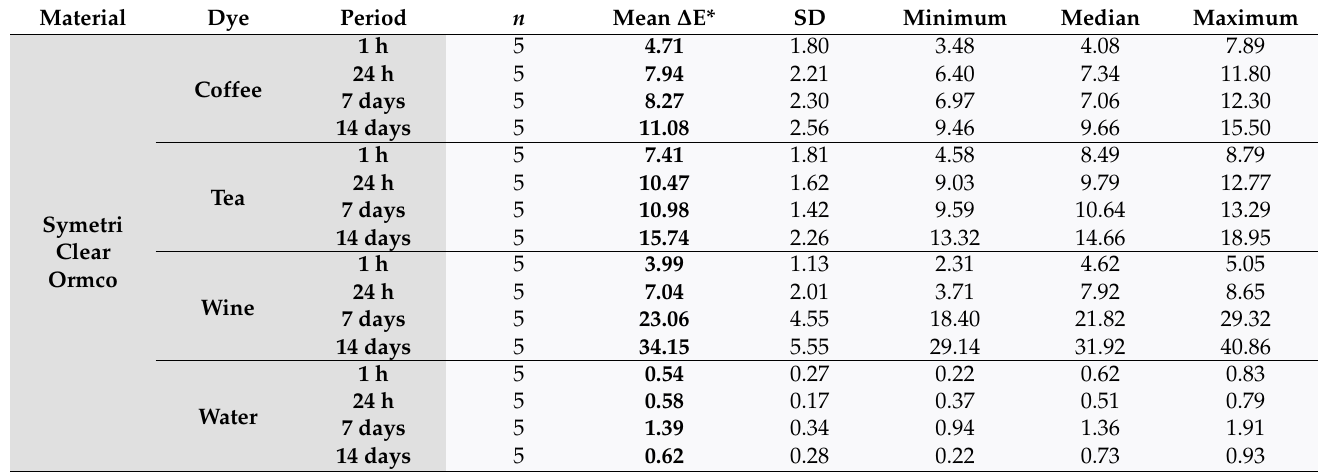
Table 5. Mean color changes of Symetri Clear brackets with respect to incubation time and type of dye.